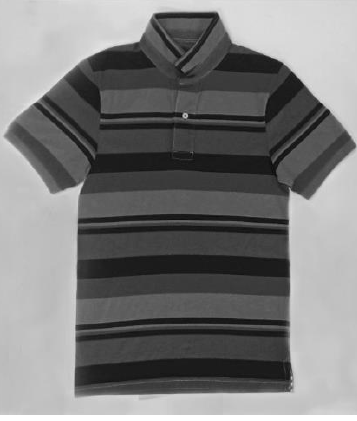
Figure 5. Grayscale image.